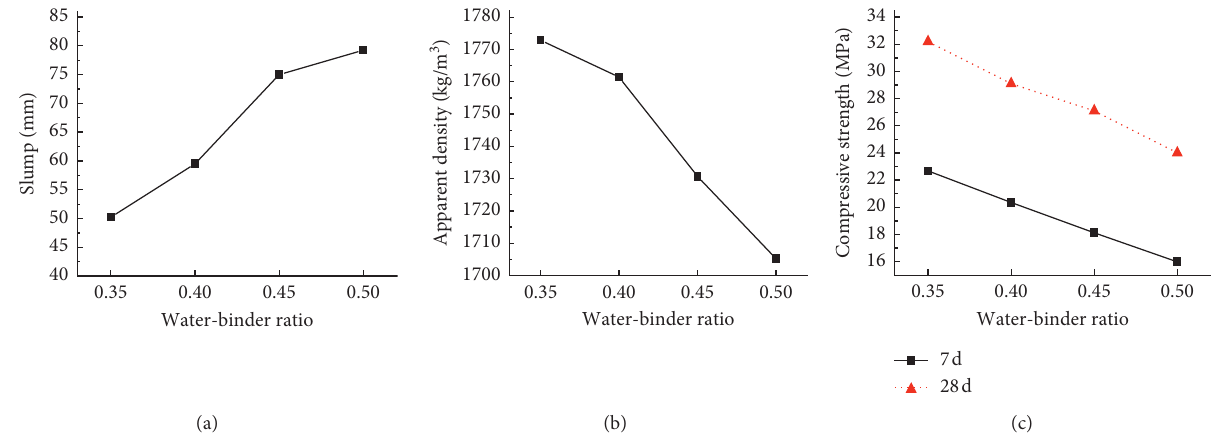
Figure 1: Curves of relationship between water-binder ratio and performance of desert sand ceramsite concrete. (a) Trend curve of slump. (b) Trend curve of 28days’ natural apparent density. (c) Trend curve of 7 and 28days’ tube crushing